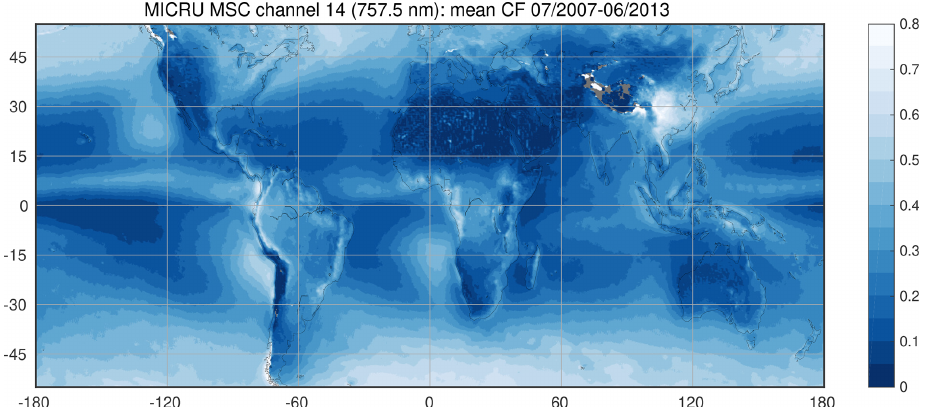
Figure F3. The 6-year average of MICRU MSC channel 14 cloud fraction measurements recorded between 1 July 2007 and 30 June 2013. Areas without data are plotted in gray.